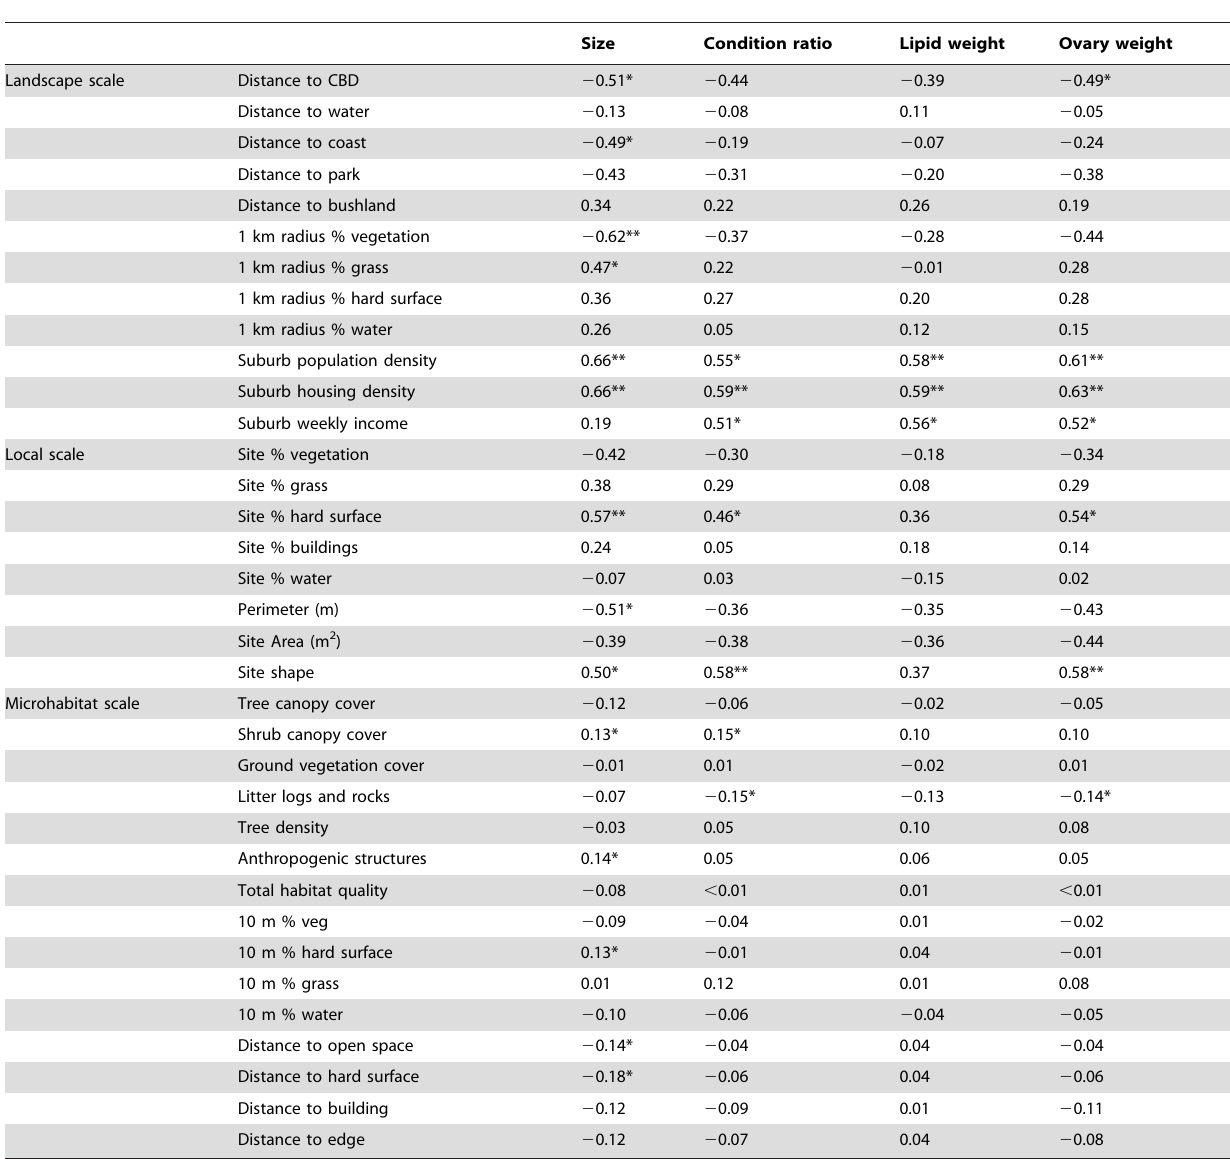
Table 1. Pearson R correlations between landscape variables at multiple scales and spider morphology (*P , 0.05, **P , 0.01).